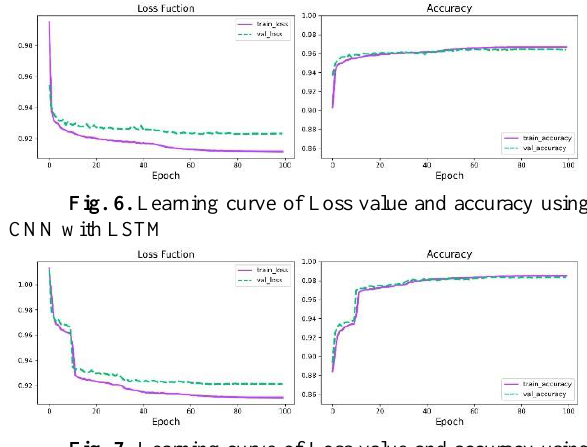
Fig. 7. Learning curve of Loss value and accuracy using